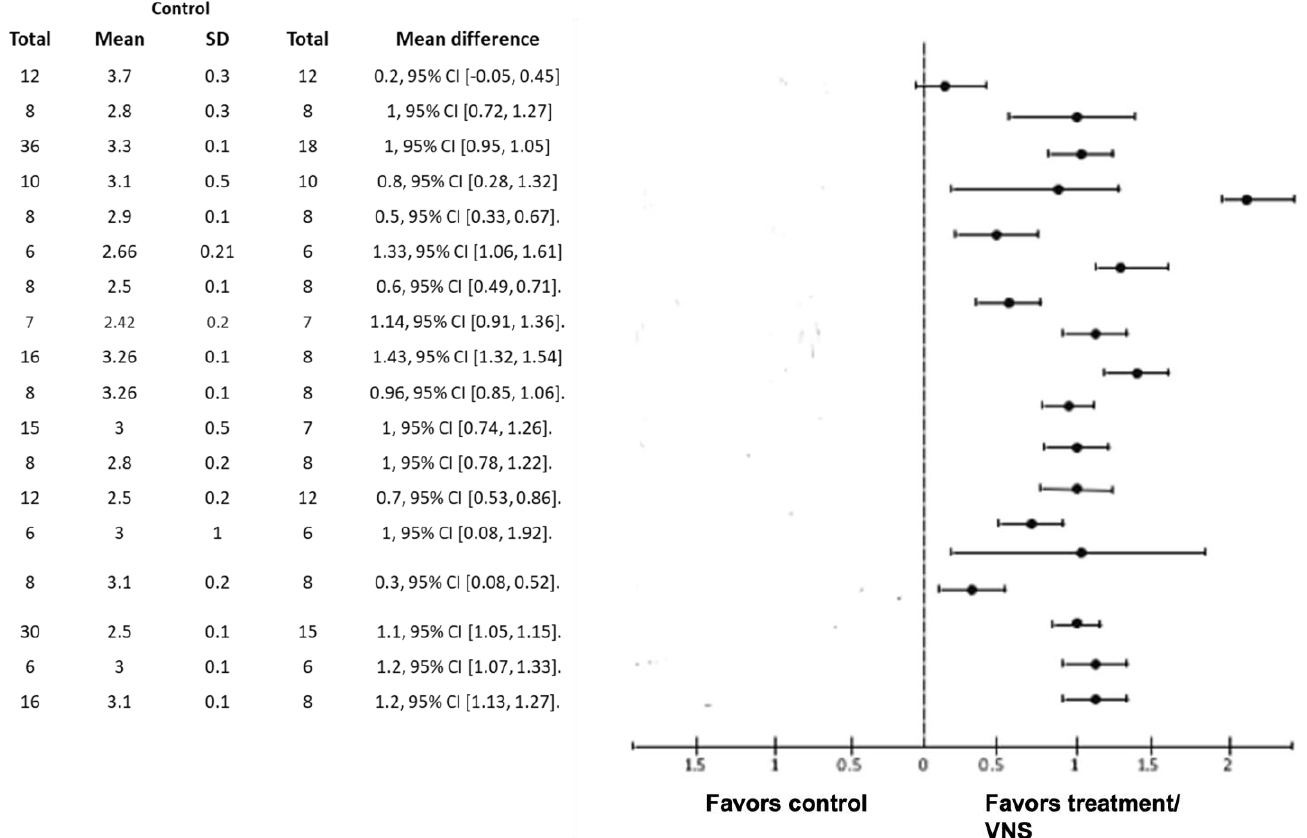
Figure 2. Forest plot: the outcome of vagus nerve stimulation (VNS) on neurological deficit score. The effect of each study (“favors control”, “favors treatment”, or “no effect”) was estimated through the standardized mean difference (horizontal axis). The dashed vertical line at 0 indicates that the study was determined to have “no effect”. The horizontal bars in each chart plot represent the mean difference with a 95% confidence interval for each study [21 – 32,35,38 – 42,49].